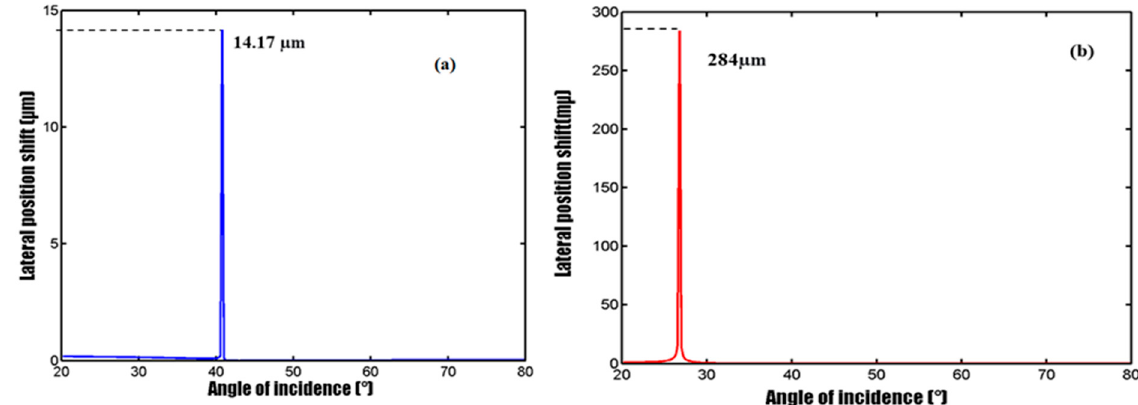
Figure 2. Simulation results of GH lateral position shift ( a ) with a gold substrate, ( b ) with the SMCW structure.